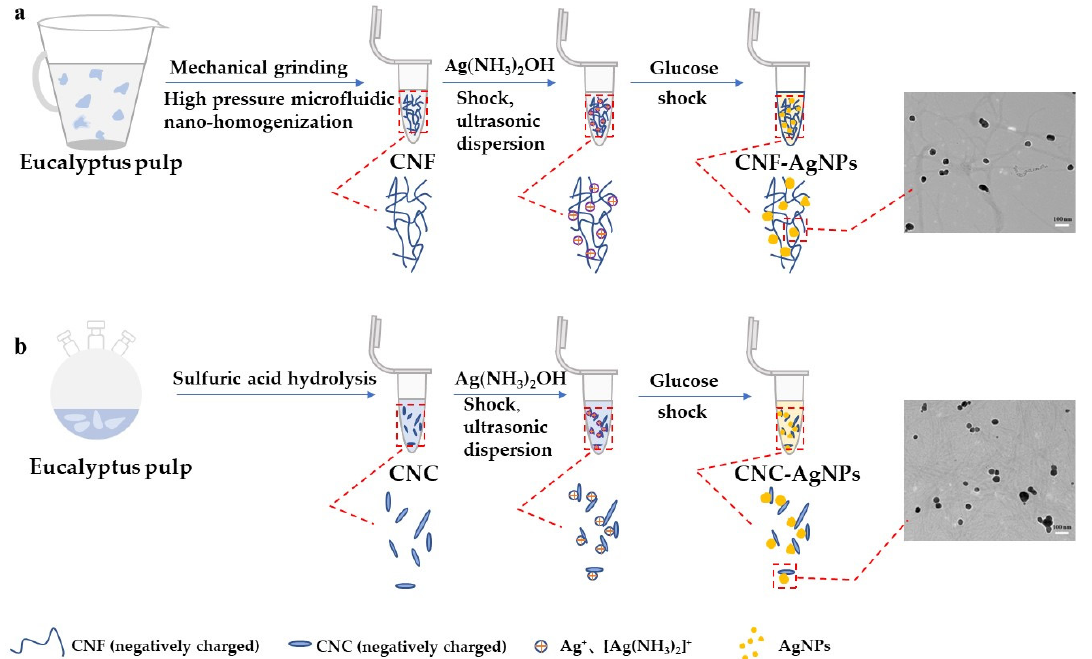
Figure 9. The preparation scheme of AgNPs assisted by nanocellulose as a carrier and stabilizer. (( a ), CNF was prepared by mechanical method from eucalyptus fiber to assist in the synthesis of AgNPs; ( b ), CNC was prepared from eucalyptus fiber by sulfuric acid hydrolysis method to assist in the synthesis of AgNPs).